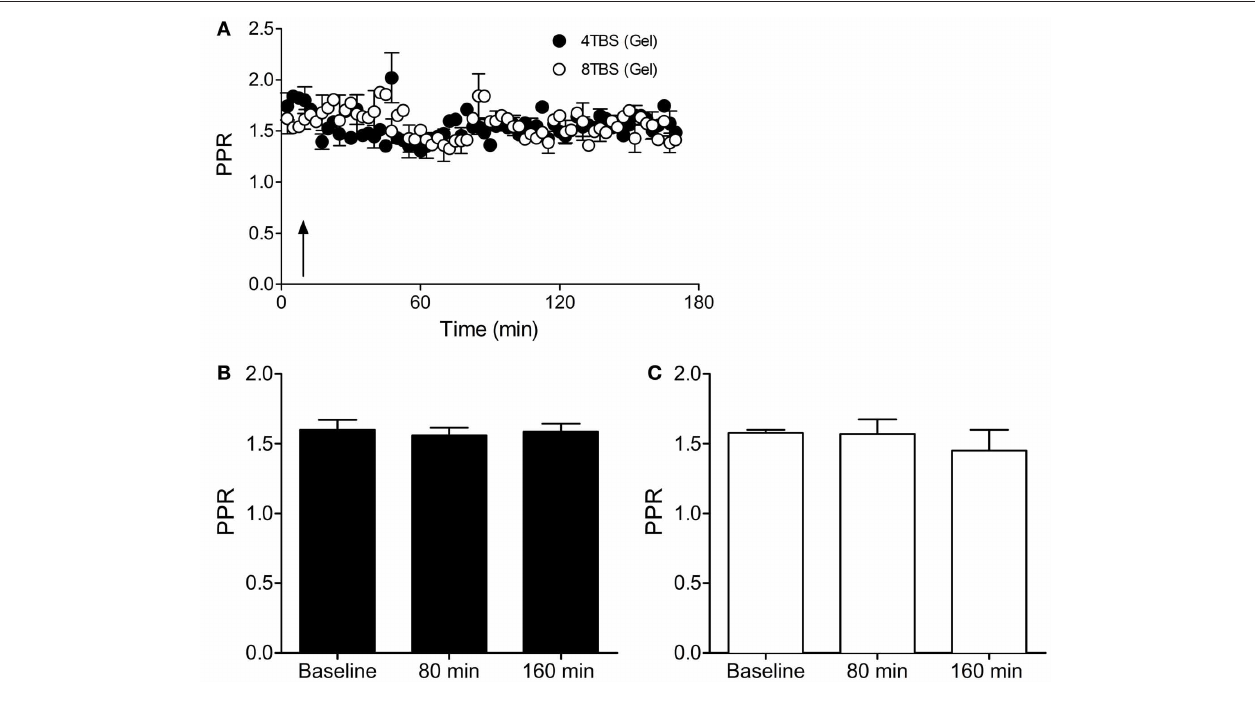
FIGURE 6 | Inhibition of postsynaptic translation with gelonin abolishes the enhanced Pr associated with LTP2 and LTP3. (A) PPR data in slices stimulated with 4TBS and 8TBS (at time point indicated by arrow) with gelonin in the patch pipette internal solution. (B) Bar graph showing mean